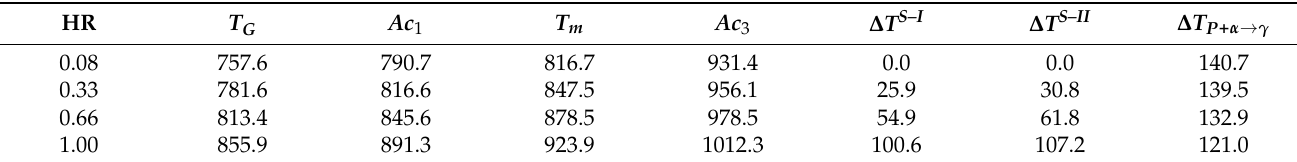
(cid:39) Ae = 793.11 ◦ C temperature. In Table 2, the critical temperatures compendium 1 is indicated, as well as the overheating values by stages as a function of the heating rate. Table 2. Critical austenite formation temperatures as a function of heating rate: 0.08, 0.33, 0.66 and 1.00 ◦ C s − 1 . ∆ T S–I , overheating–first stage; ∆ T S–II , overheating–second stage; ∆ T P + α → γ , overall transform